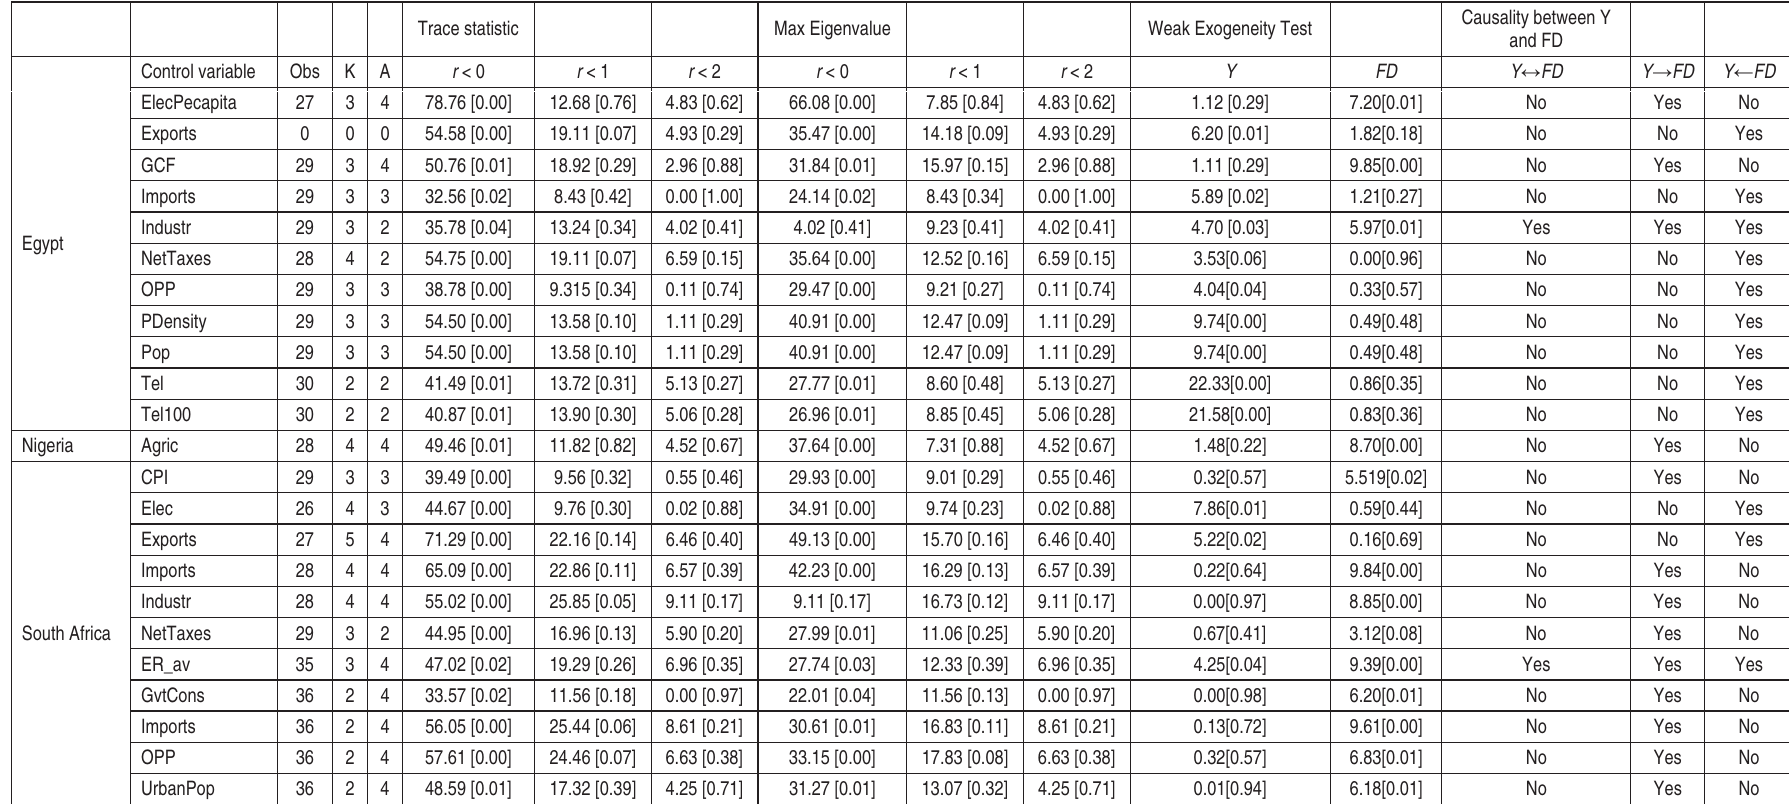
Table 5. Cointegration and weak exogeneity test results for Egypt, Nigeria and South Africa: S-Size and per capita GDP Trace statistic Max Eigenvalue Weak Exogeneity Test